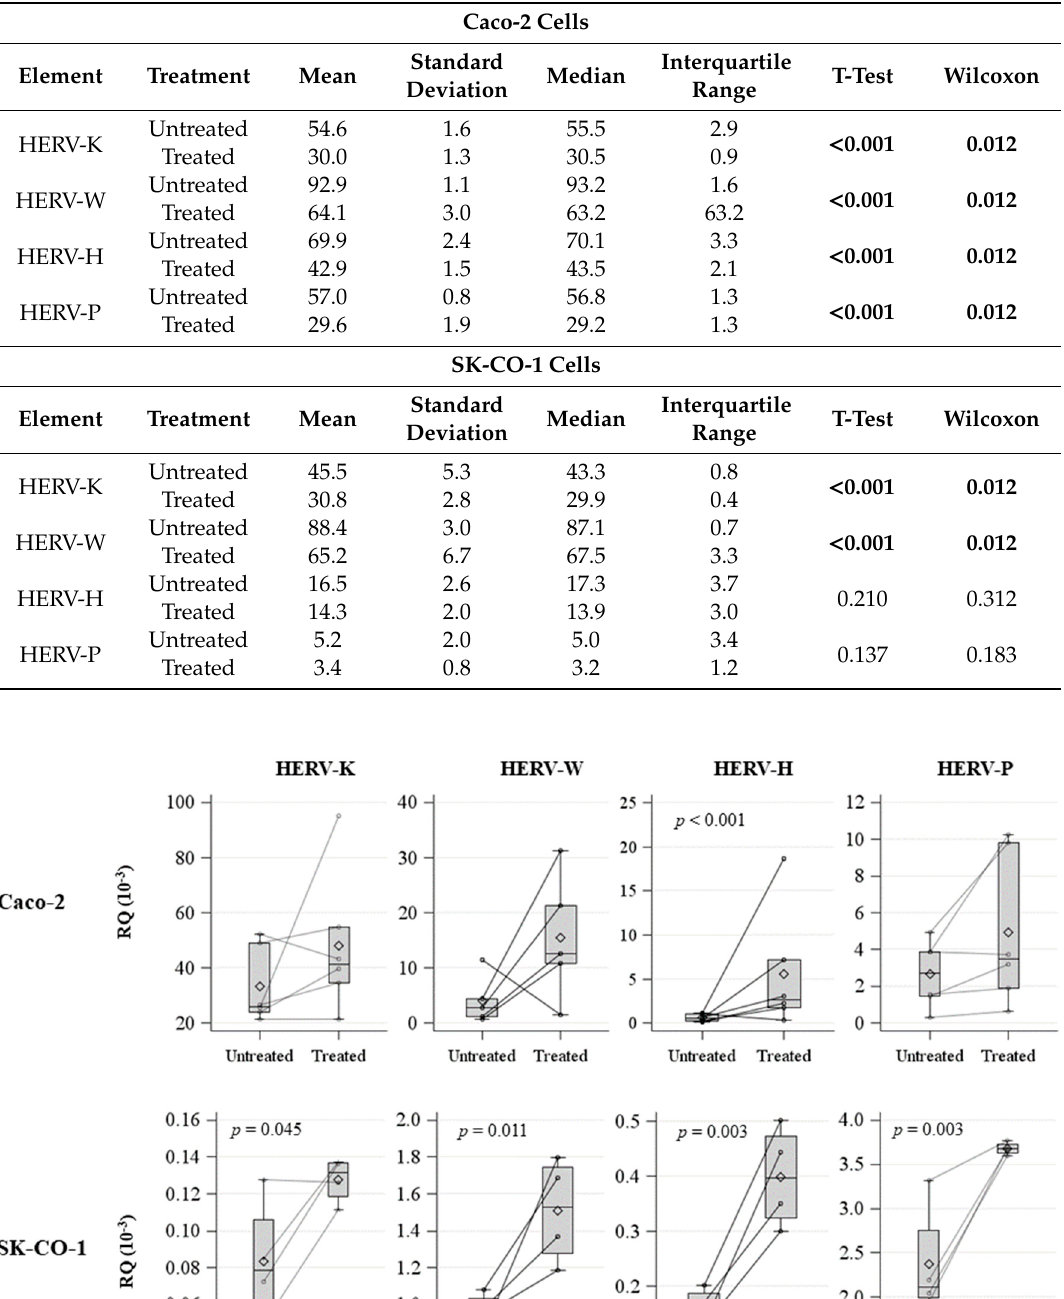
Table 2. Association of HERV LTRs methylation between untreated- and decitabine-treated- Caco-2 and SK-CO-1 cells. T-test and Wilcoxon p -values in bold are statistically significant.